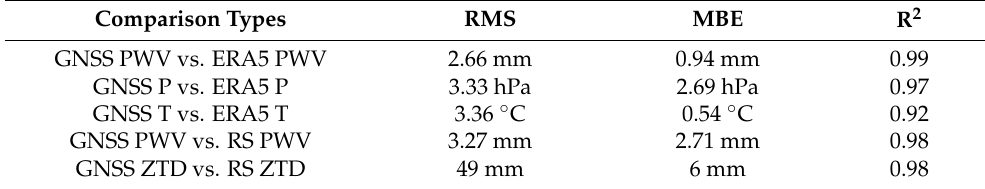
Figure 4. Precision comparison of ERA-5-derived and GNSS-derived PWV, P and T data, where ( a1 – c1 ) represent the comparisons of PWV derived from GNSS and ERA-5, respectively, ( a2 – c2 ) represent the P comparison derived from meteorological station and ERA-5, respectively, ( a3 – c3 ) represent the T comparison derived from meteorological station and ERA-5, respectively. Table 3. Precision comparison of RMS, MBE, and R 2 of GNSS, RS, and ERA-5 data.